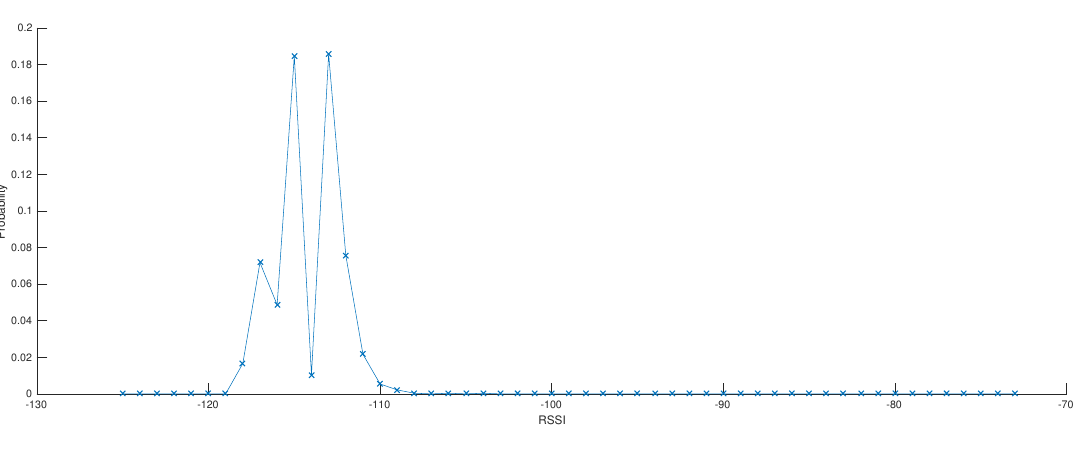
Figure 9. Probability-density function of RSSI (dBm) observed with LoRa sensors over a 2 month